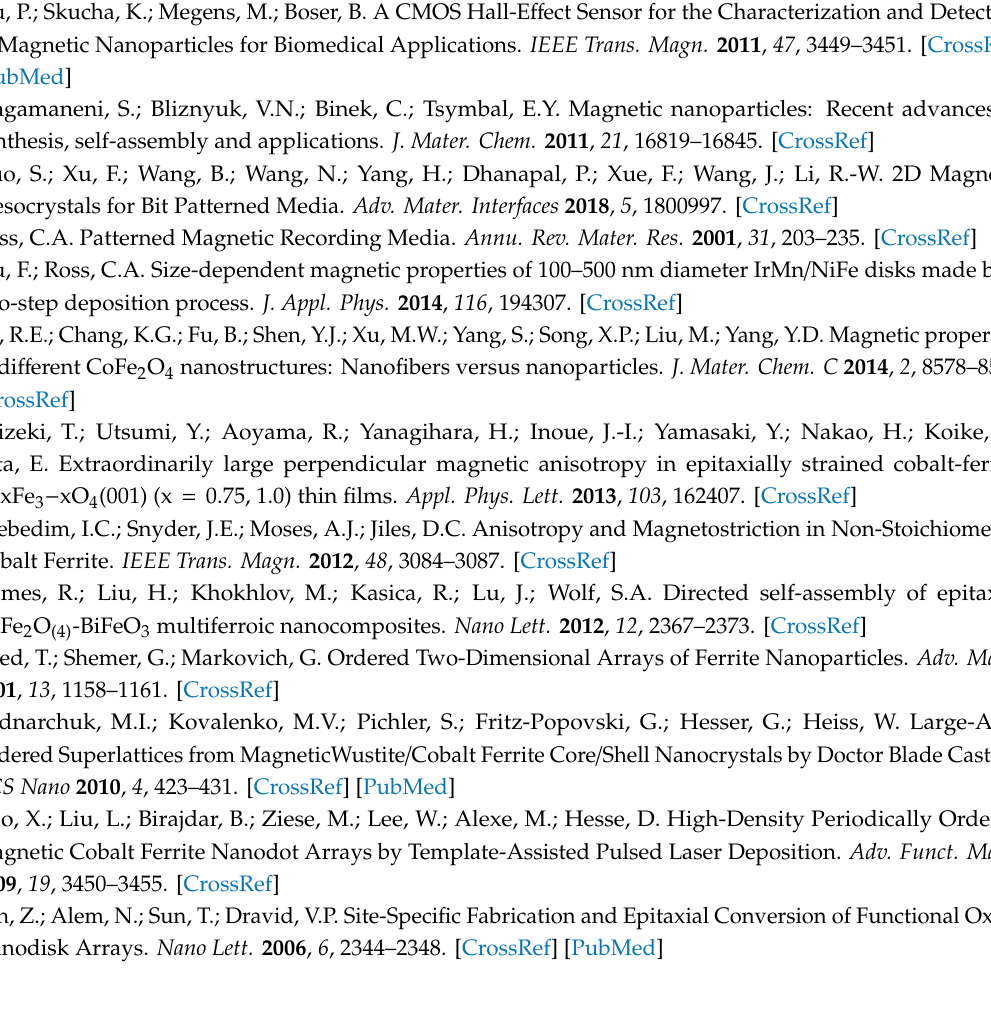
Figure S1: Schematic representation of the spinel structure; Figure S2: 1D GISAXS plots along the q z direction of the CFO nanodots prepared from di ff erent templates; Table S1: Structural parameters obtained from the simulated and experimental GISAXS results; Table S2: Two-body simulation results at Fe K-edge of the CFO standard and the nanodots annealed at 950 ◦ C; Table S3: Three-body simulation results at Fe K-edge of the CFO standard and the nanodots annealed at 950 ◦ C; Table S4: Magnetic parameters of the